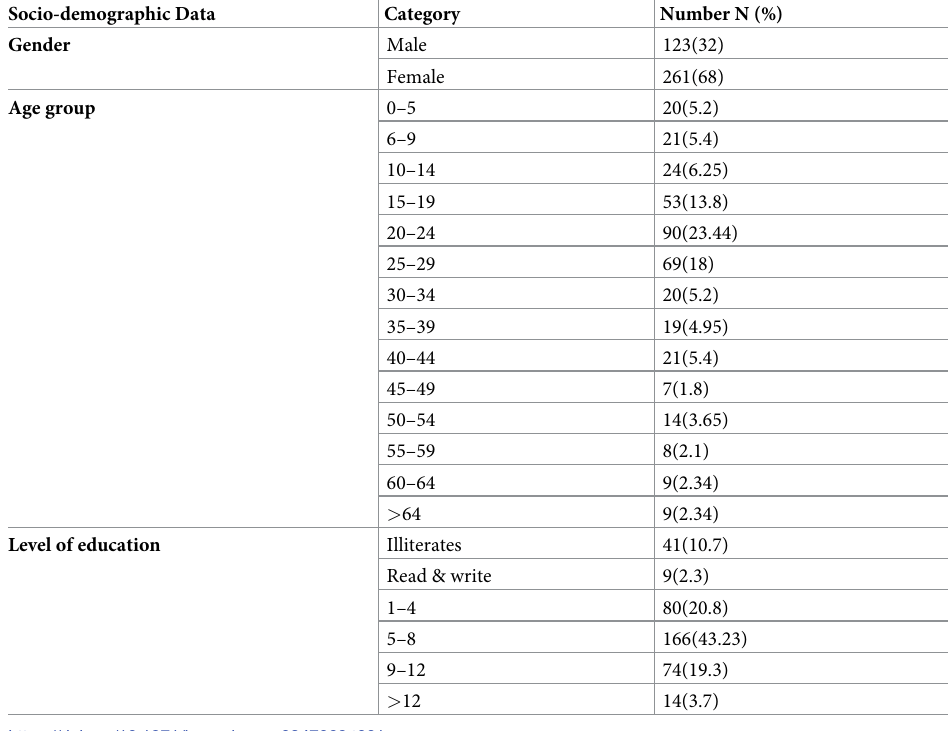
Table 1. Socio-demographic characteristics of patients examined for stool, Jimma health center, Southwest, Ethi- opia (n = 384). Socio-demographic